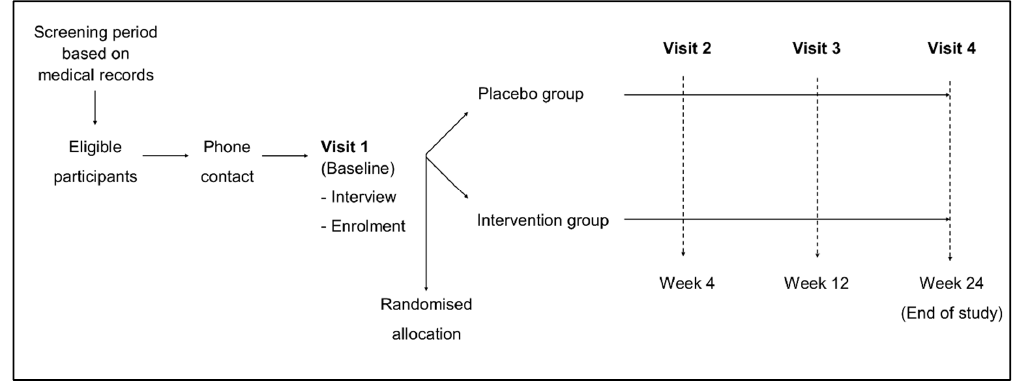
Figure 1. General diagram of the study.